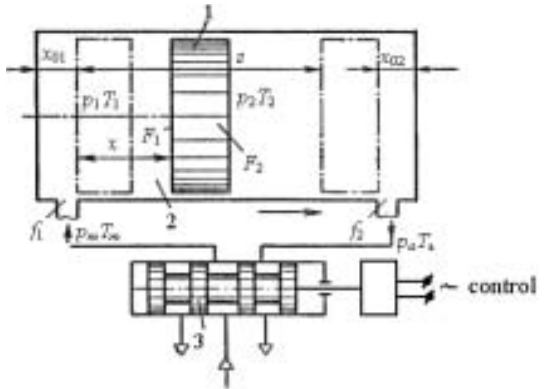
Fig. 3. The scheme of two-way operation pneumatic drive: 1–piston, 2–cylinder, 3- electro-magnetic impulse valve (air distributor).